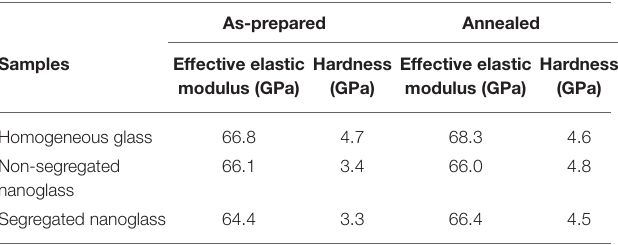
TABLE 1 | Effective elastic modulus and hardness obtained by nanoindentation of as-prepared and annealed samples.